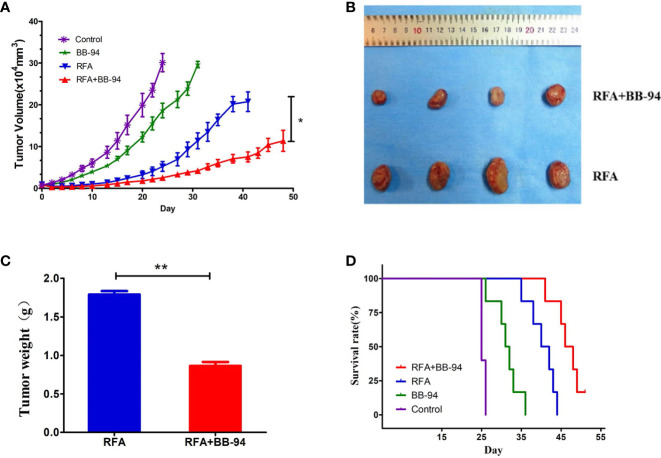
Comparison of tumor growth rate. Long-term outcomes after different treatments. (A) The tumor growth curves at different treatment groups. (B) The tumors in the RFA group and the BB-94+RFA group 30 days after RFA. (C) Quantitative analysis of the tumor weight in the RFA group and the BB-94+RFA group 30 days after RFA. (D) The survival curves at different treatment groups. *P < 0.05, **P < 0.01.